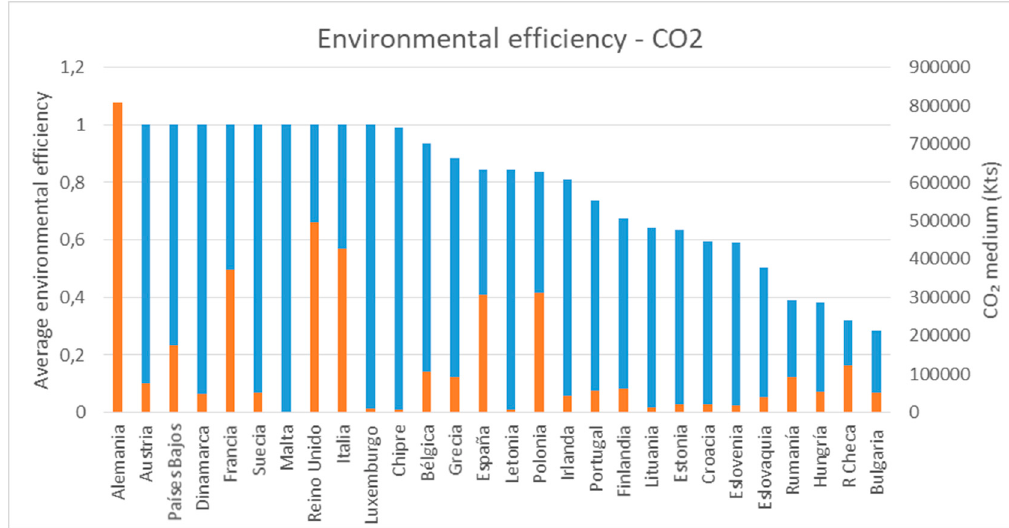
Figure 13. Comparison between the average environmental efficiency obtained with the mean between the DEA Methods 1 and 2 and average CO 2 . Source: self made.